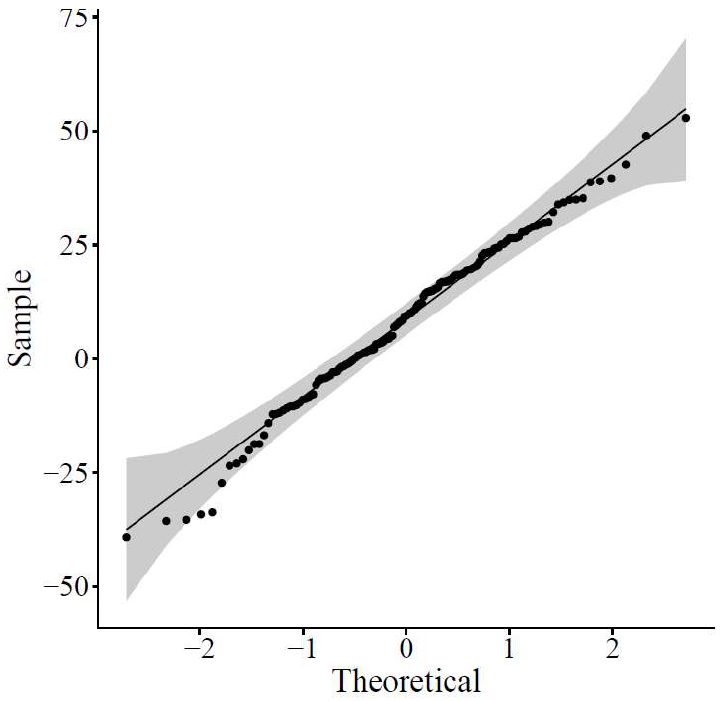
Figure 1. Annual real rates of linear return. Quantile-quantile plot.